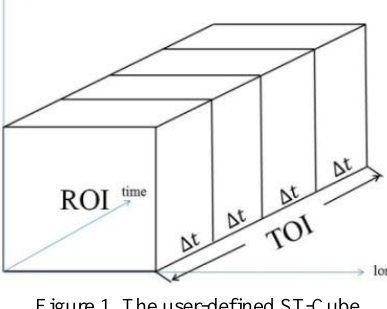
Figure 1. The user-defined ST-Cube